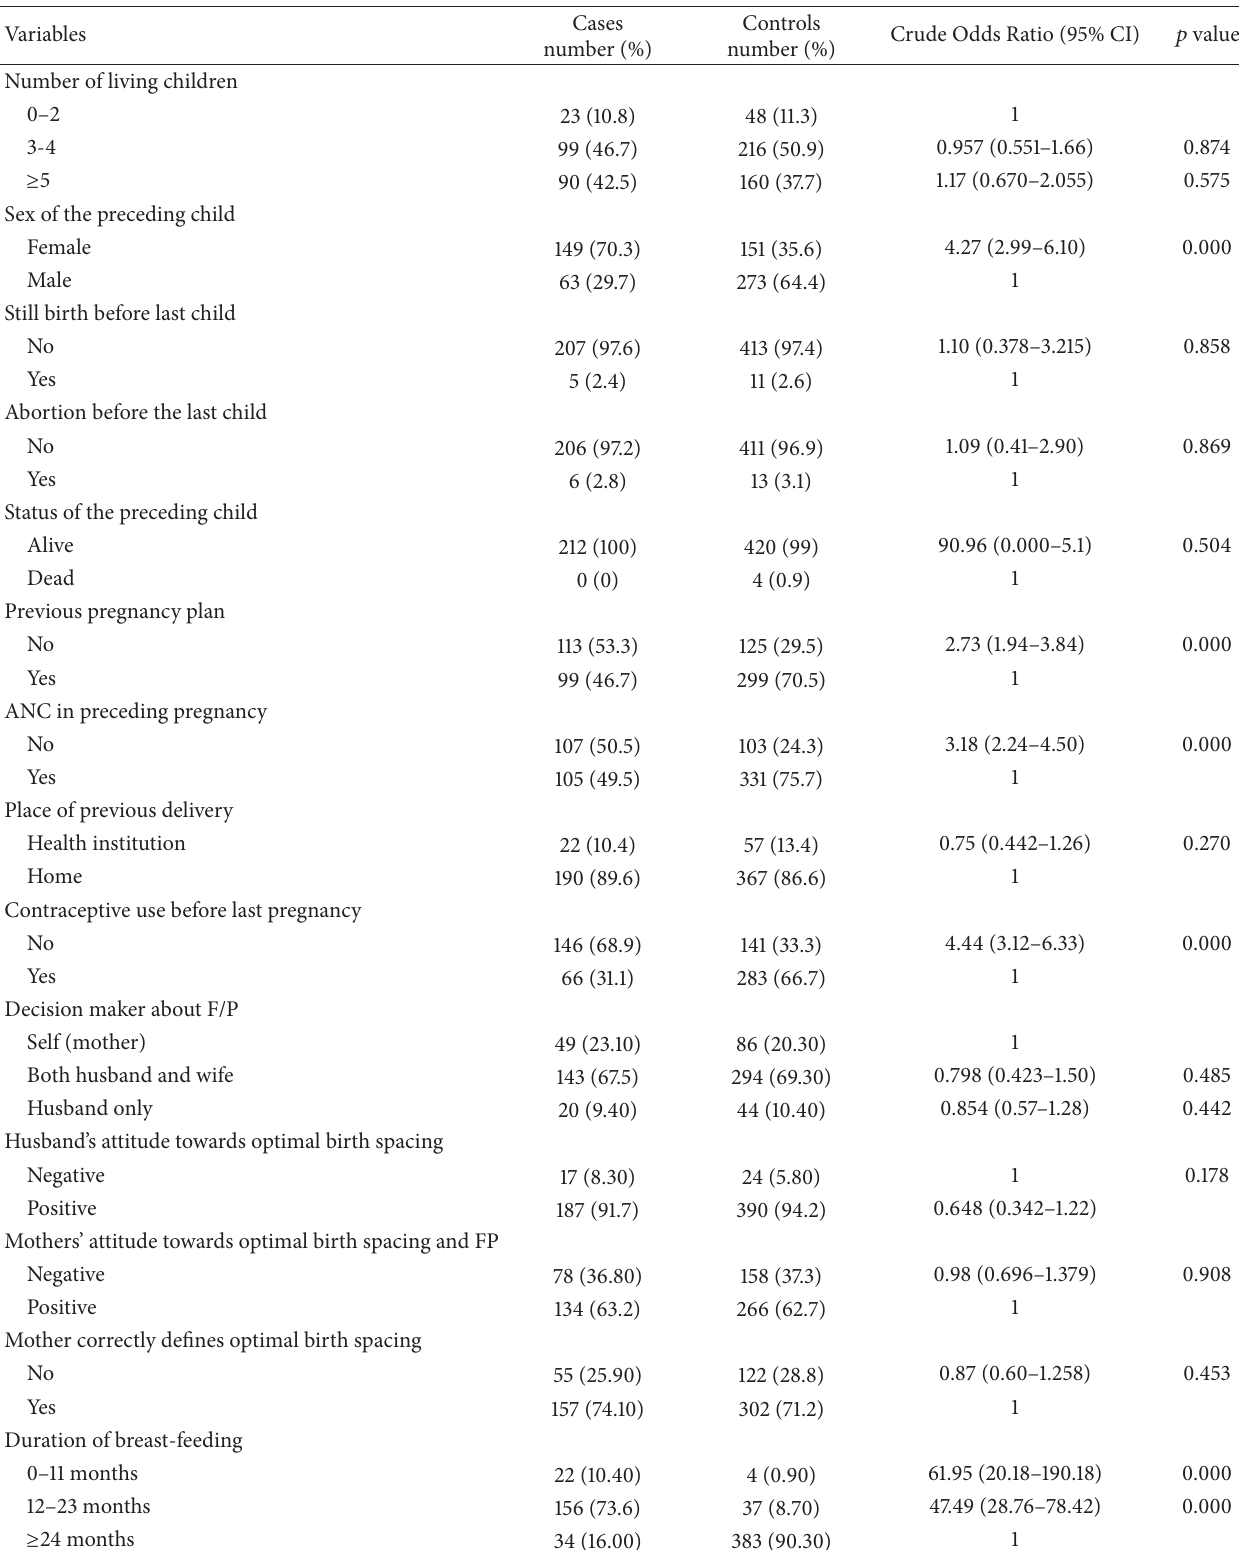
Table 2: Univariate and bivariate analysis of obstetric, breast-feeding, and contraception history of child-bearing age mothers in Arba Minch Zuria District, Gamo Gofa Zone, Ethiopia,